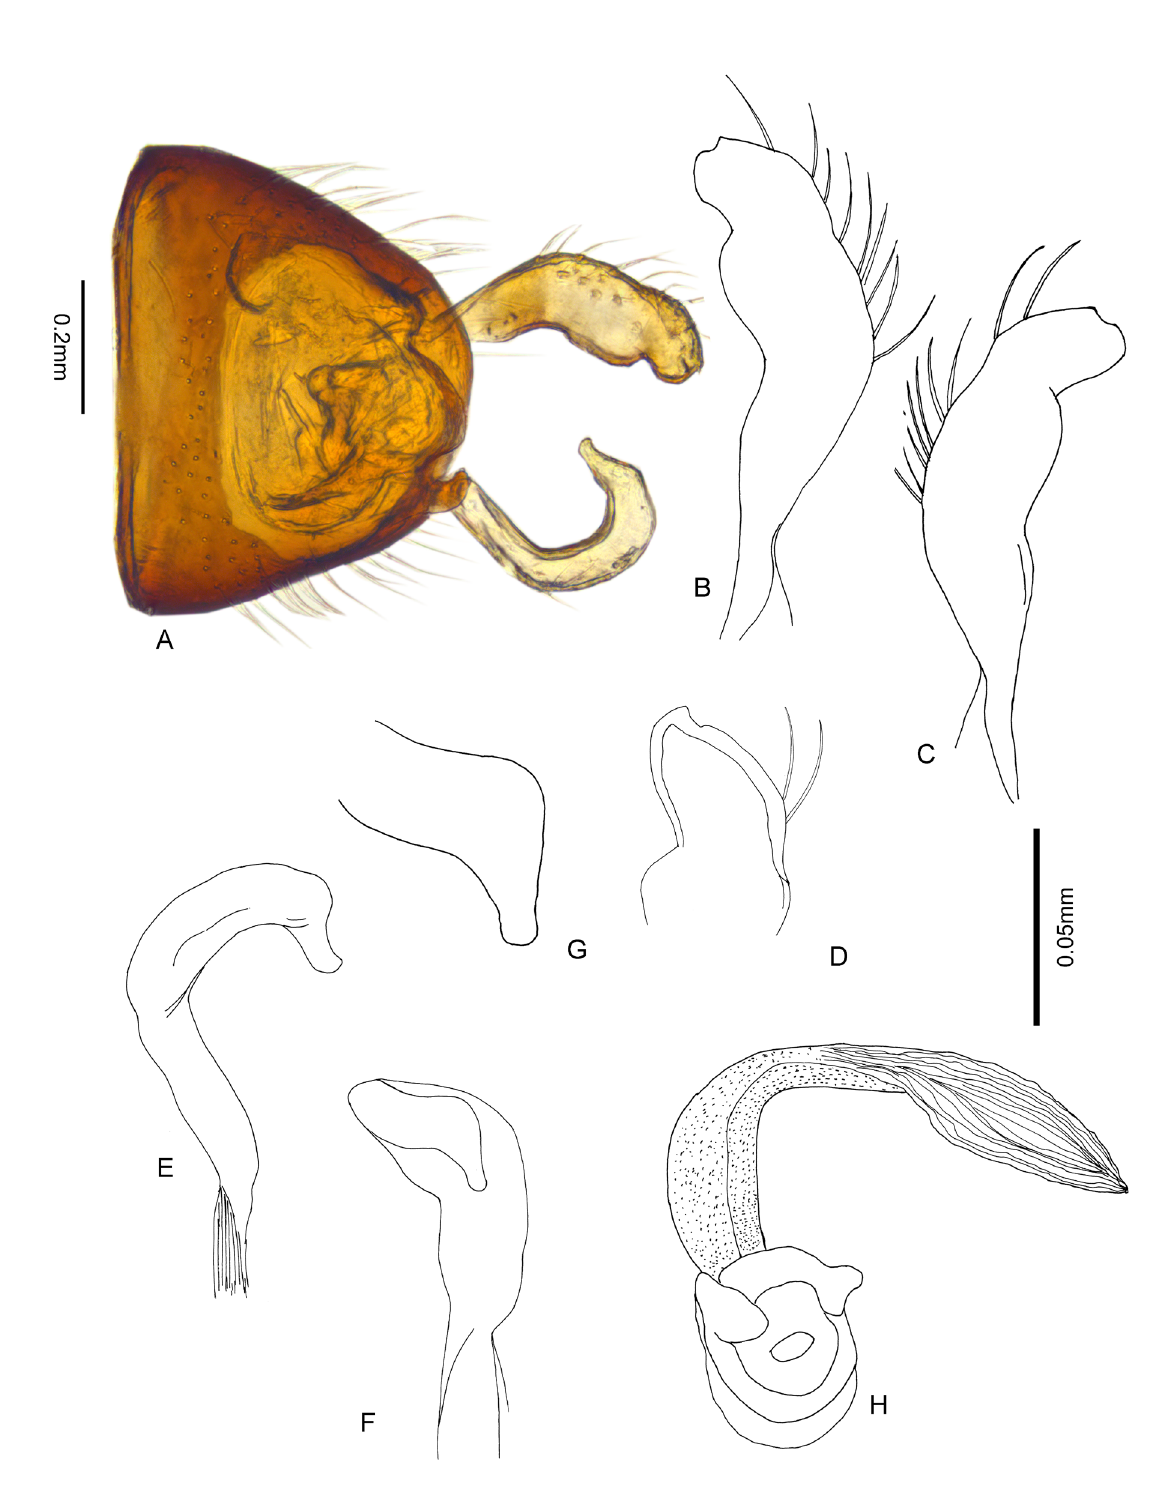
Fig. 13. Male genitalia of Ernestinus ramkeshariae Yasunaga & Ishikawa, 2016, UASB. A . Genital capsule in dorsal view. B–D . Right paramere. B . Dorsal view. C . Ventral view. D . Apex, magnified. E–F . Left paramere. E . Dorsal view. F . Lateral view. G . Apex, magnified. H . Aedeagus in dorsal